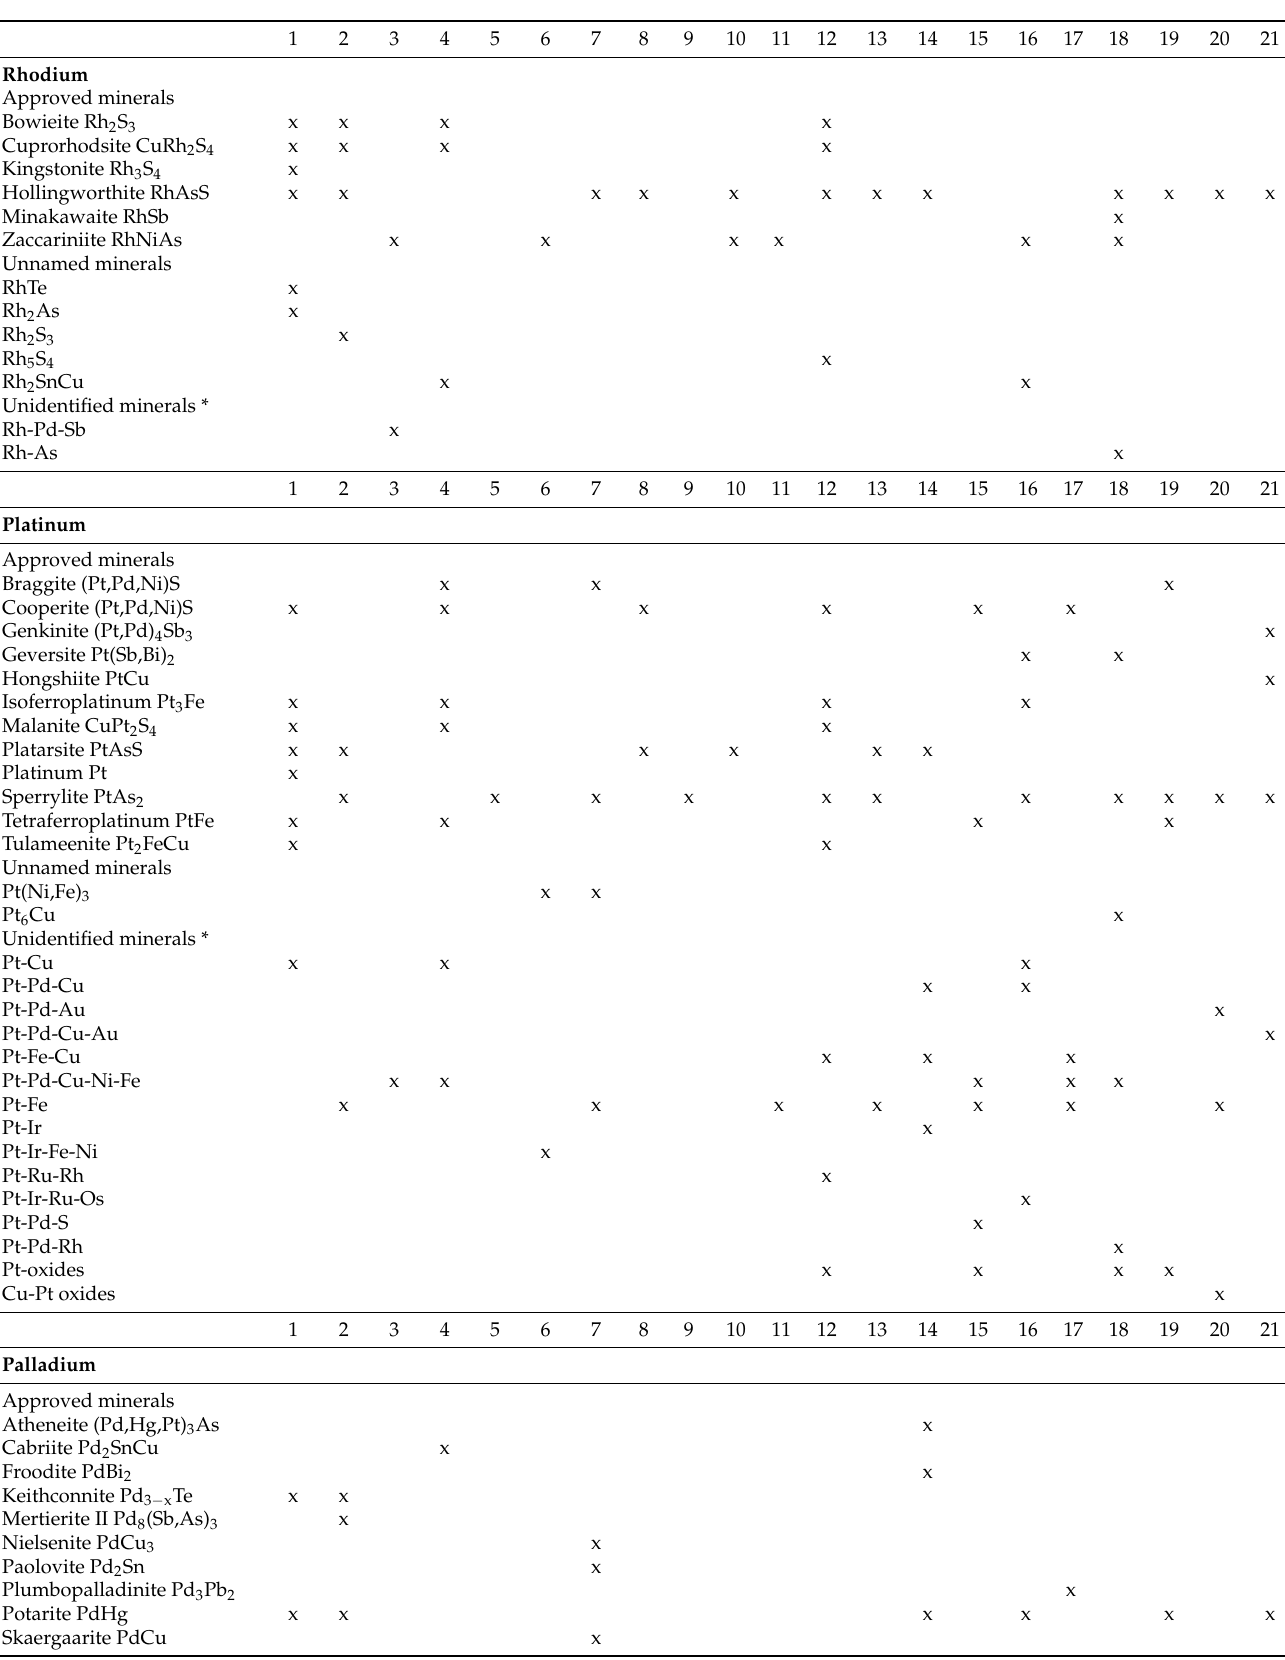
Table 3. PPGM identified in the PPGE-enriched ophiolitic